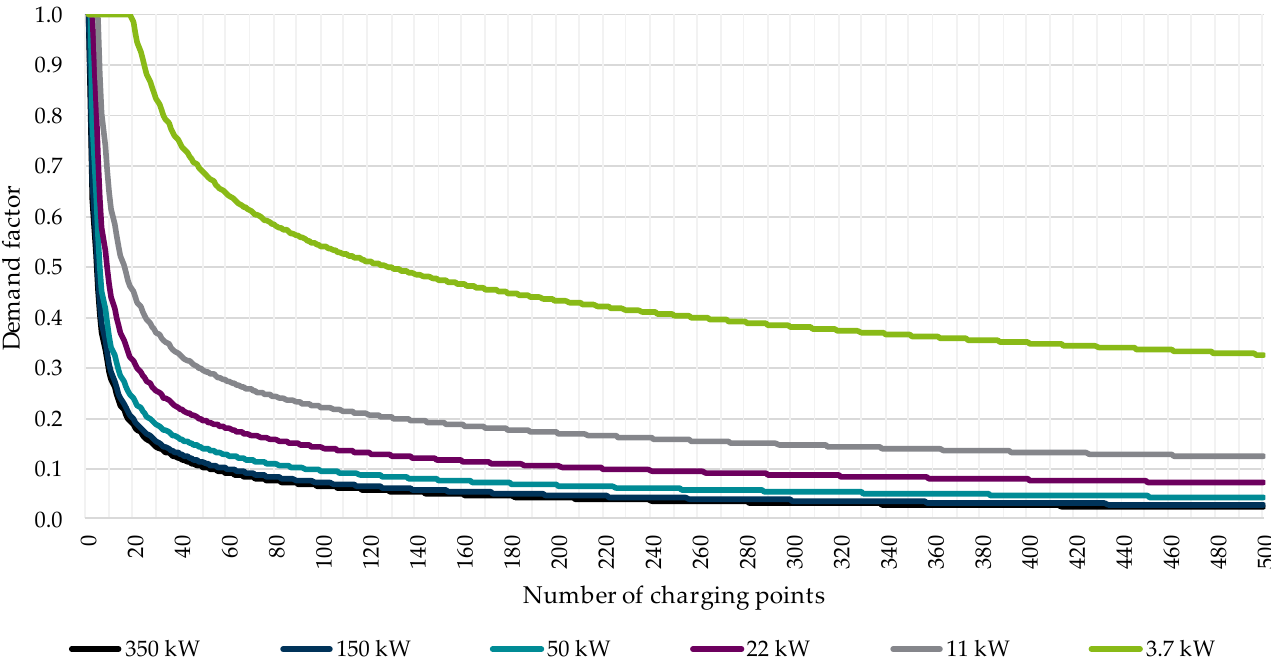
Figure 14. Demand factors (ordinate) for the area type “Urban Region: Small-town Area, Village Area” and six charging powers.